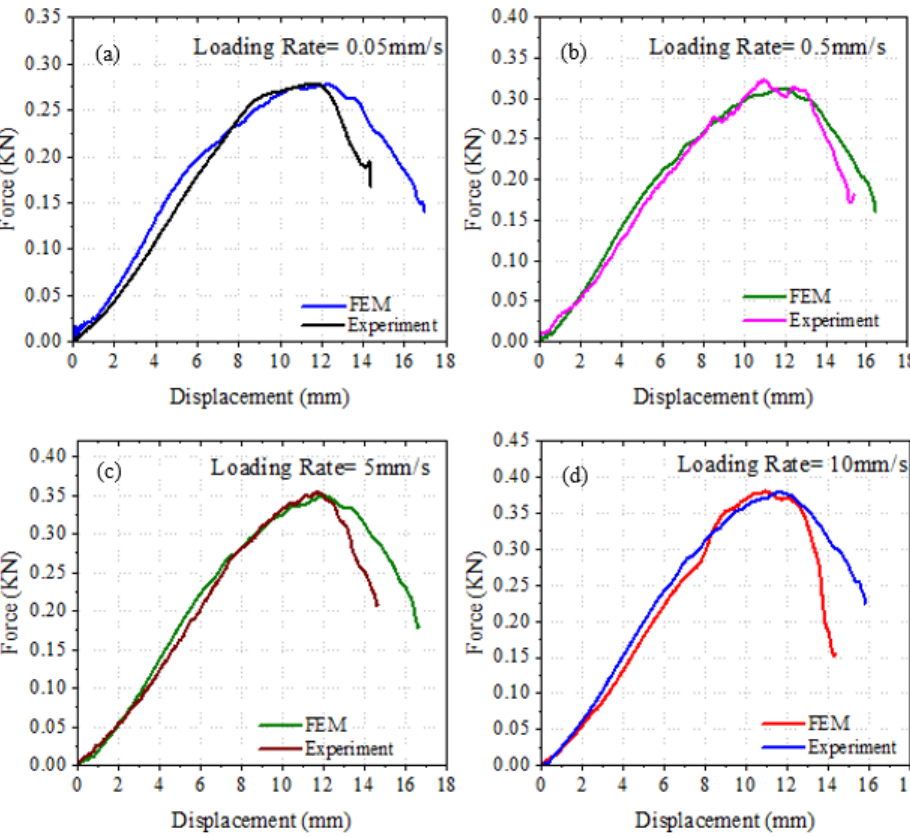
Figure 9. Comparison between experimental and FEM predictions for the behavior of short-span beams; ( a ) Loading rate = 0.05 mm/s, ( b ) Loading rate = 0.5 mm/s, ( c ) Loading rate = 5 mm/s, ( d ) Loading rate = 10 mm/s.